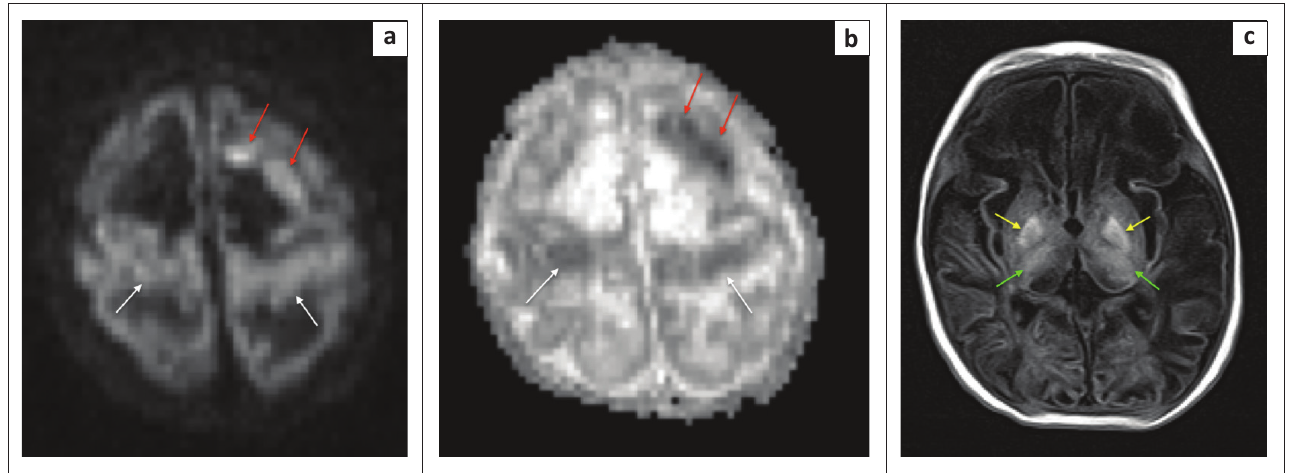
FIGURE 21: A 15-day-old female child born after abruptio placentae with poor Apgar scores of 0/10 and 1/10 at 1 and 5 min, respectively. Head and body cooling were instituted but the clinical condition remained poor with seizures. The diffusion sequence (a) shows resolving diffusion signal abnormality (white arrows) at the perirolandic cortex and paracentral lobules bilaterally but there is persistent restricted diffusion at the left frontal lobe (red arrows) with ADC shortening in (b) because of watershed zone ischemia. (c) Note the established ischemic injury of the thalami (green arrows) and lentiform nuclei (yellow arrows) with T1-weighted hyperintensity. This is in keeping with evolving mixed subtype of hypoxic ischemic brain injury in the early neonate.